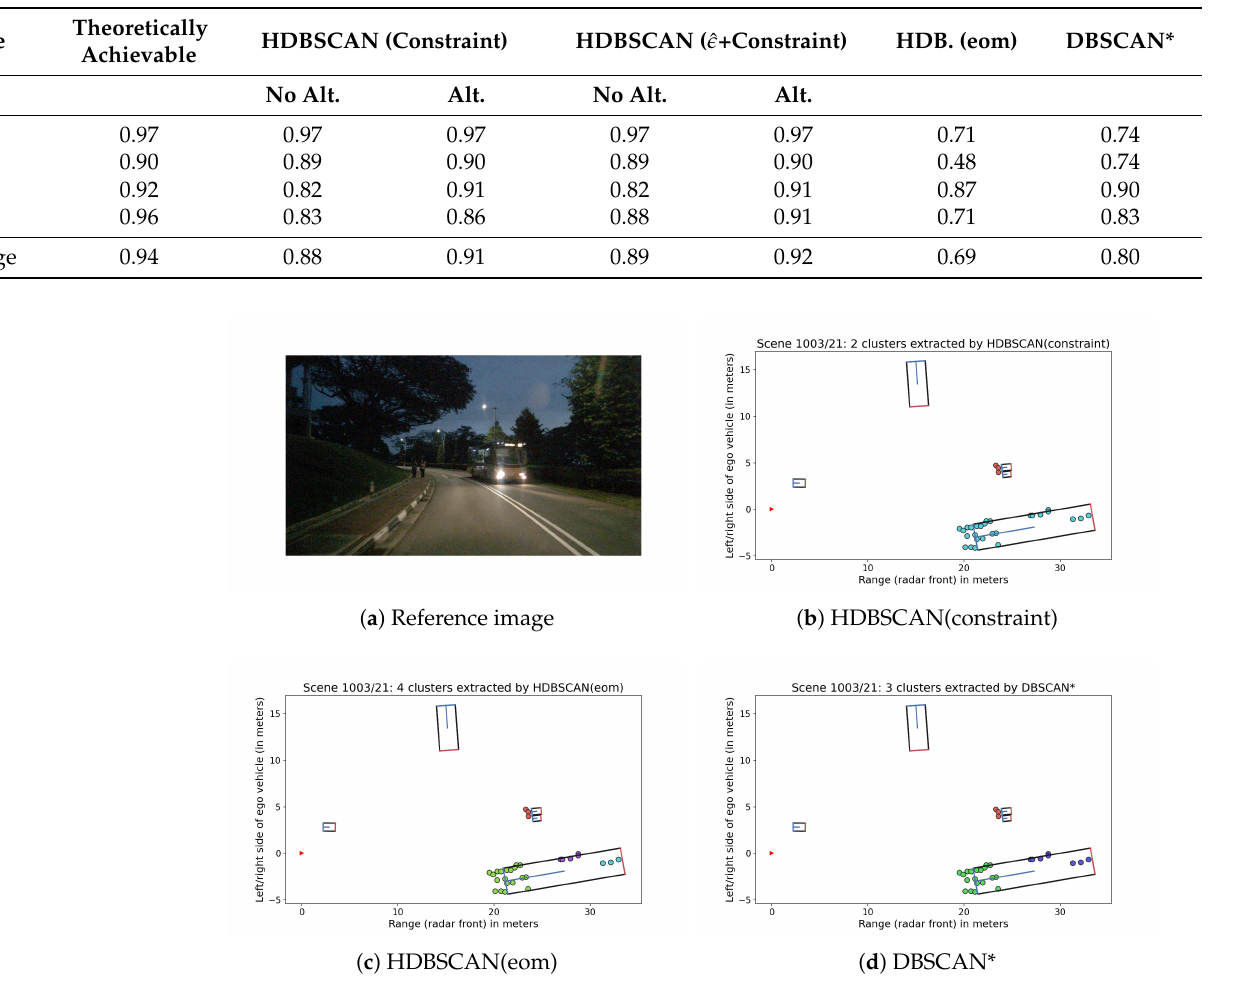
Figure 2. Reference image from nuScenes [24] and clustering results for a sample in Scene